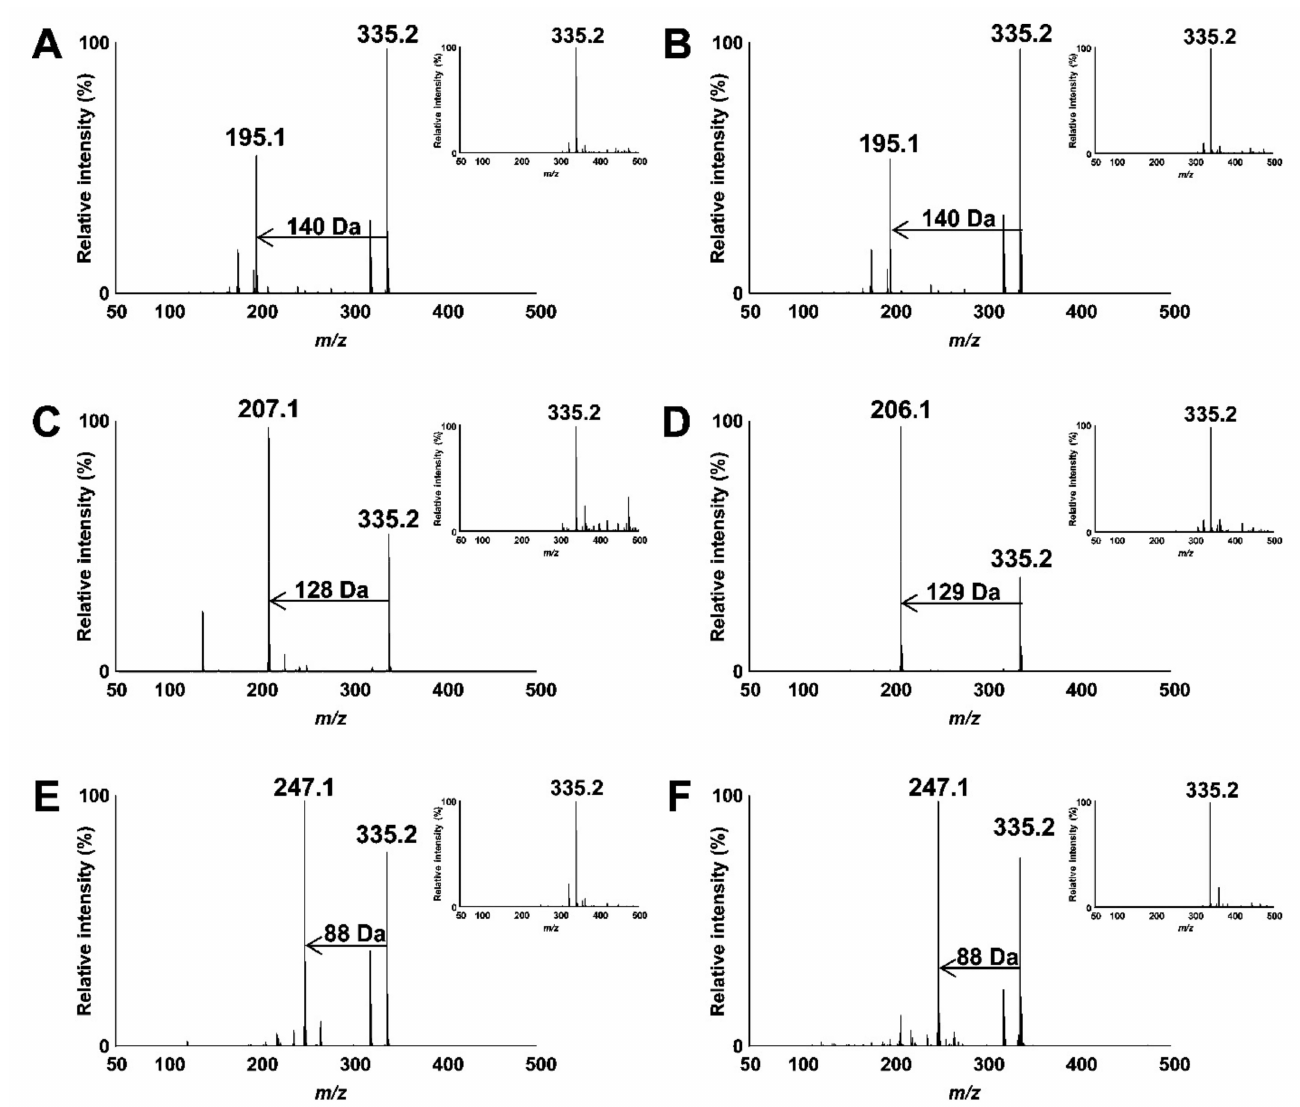
Figure 12. Mass spectra (Q1) and product-ion mass spectra (MS/MS) of HPODE isomers in the presence of sodium ion (positive mode). HPODE isomers were individually dissolved in methanol containing 0.1 mM sodium acetate. Each sample solution (37 − 89 µ M) was infused directly into a microTOF-Q II mass spectrometer at a flow rate of 300 µ L/h. Spectral data (( A ), 9-10 E ,12 Z -HPODE; ( B ), 9-10 E ,12 E -HPODE; ( C ), 10-8 E ,12 Z -HPODE; ( D ), 12-9 Z ,13 E -HPODE; ( E ), 13-9 Z ,11 E -HPODE; ( F ), 13-9 E ,11 E HPODE) were obtained under the optimized conditions. Each spectrum is representa- tive of at least a triplicate analysis. Reprinted with permission from [79]. Copyright 2015, American Chemical